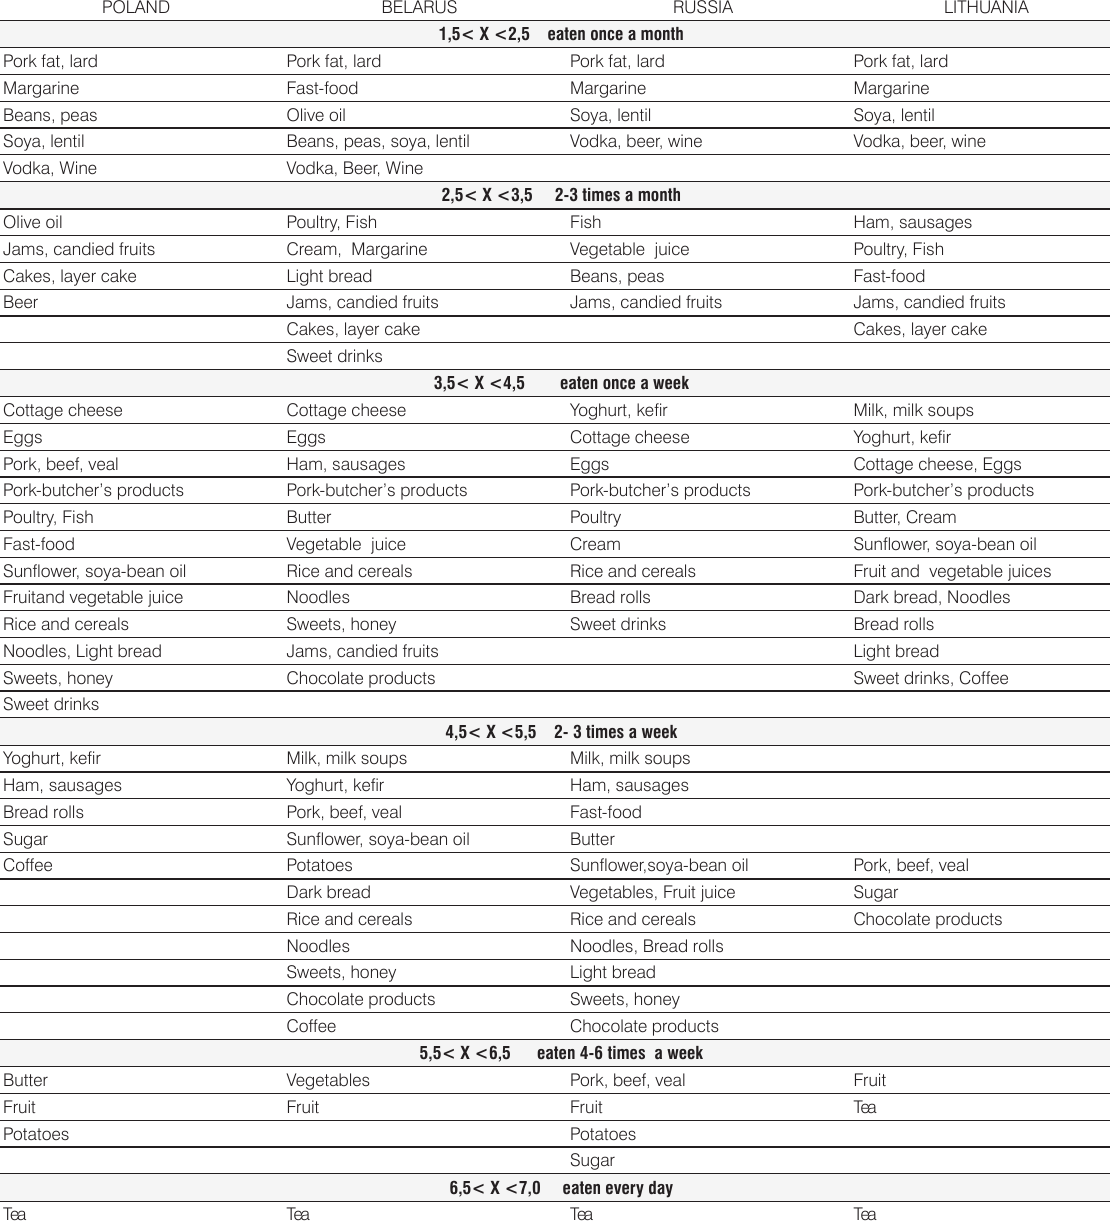
Table 6. Food products in the ranks of the consumption frequency in